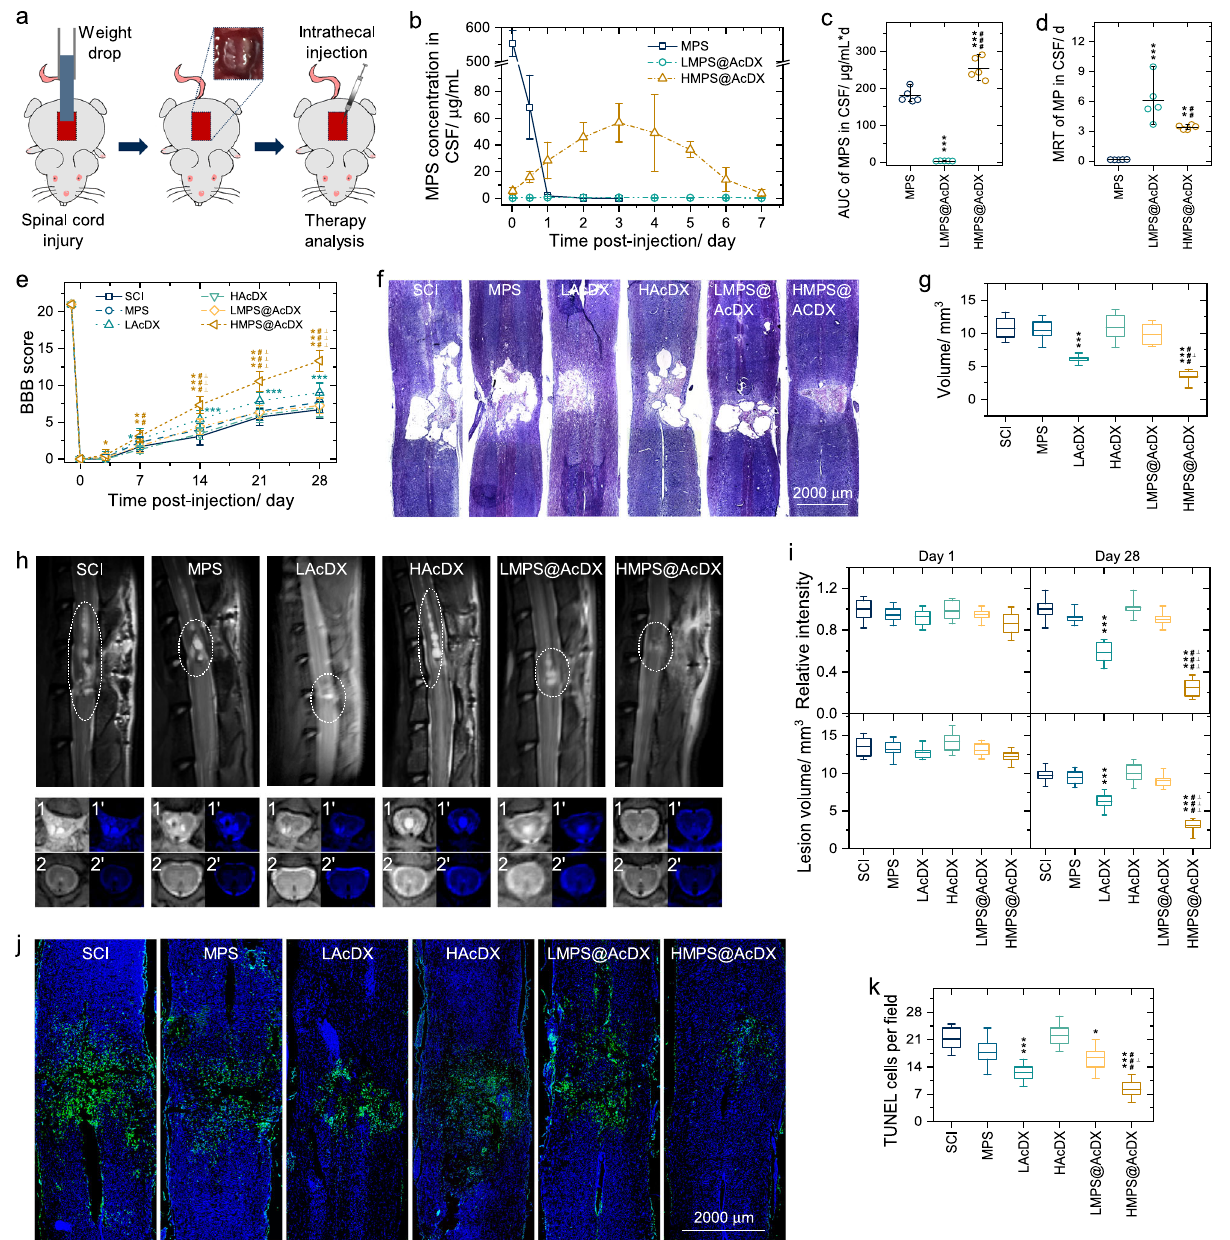
Fig. 5 HMPS@AcDX microspheres improve motor function and reduce spinal cord edema. a Microspheres were intrathecally injected within 5 min after weight drop at T10 level. b – d MPS concentration in cerebral spinal fl uid (CSF) as a function of time ( b ), and the corresponding area under curve (AUC; c ) and mean residence time (MRT; d ). n = 5 rats per time point; every rat was only sampled once. e Rats were functionally graded up to 28 days post-injury by BBB grading scale ( n = 10, 7, 8, and 9 for SCI/MPS/LAcDX, HAcDX, LMPS@AcDX and HMPS@AcDX, respectively. Data are presented as mean values ± SD for ( b – e ). f Sagittal spinal cord sections stained with Nissl display the injury area of spinal cord at day-28 post trauma. g Comparison of the lesion volume after treatment ( n = 5 per group). h Sagittal and axial spinal cord T2 weighted images at day-28 after injury. (1) & (1 ′ ) are axial images in injury epicenter, (2) & (2 ′ ) are axial images in far-injury area, (1 ′ ) & (2 ′ ) are axial color maps transformed from (1) and (2) normal axial images and the blue color represents the edema signal. i Intensity ratio for the signal of lesion to normal spinal cord and cord volume determined for consecutive slices at day-1 and day-28 post injury ( n = 5 per group). j TUNEL-positive apoptotic cells (in green) in sagittal spinal cord sections at day-1 post trauma. The nuclei of all cells were stained with DAPI (in blue). k Comparison of the number of TUNEL-positive cells after treatment ( n = 6 per group). Box plots show the minimum value, the fi rst quartile, the median, the third quartile, and the maximum value. The intervention groups were compared with SCI group (*); HMPS@AcDX group was compared with LMPS@AcDX group ( # ) and LAcDX group ( ⊥ ); *, ⊥ P < 0.05, **, ## P < 0.01, ***, ### , ⊥⊥⊥ P < 0.001. Statistical signi fi cance was analyzed using one-way ANOVA followed by Fisher ’ s post-hoc test. Exact P values are given in the Source data fi